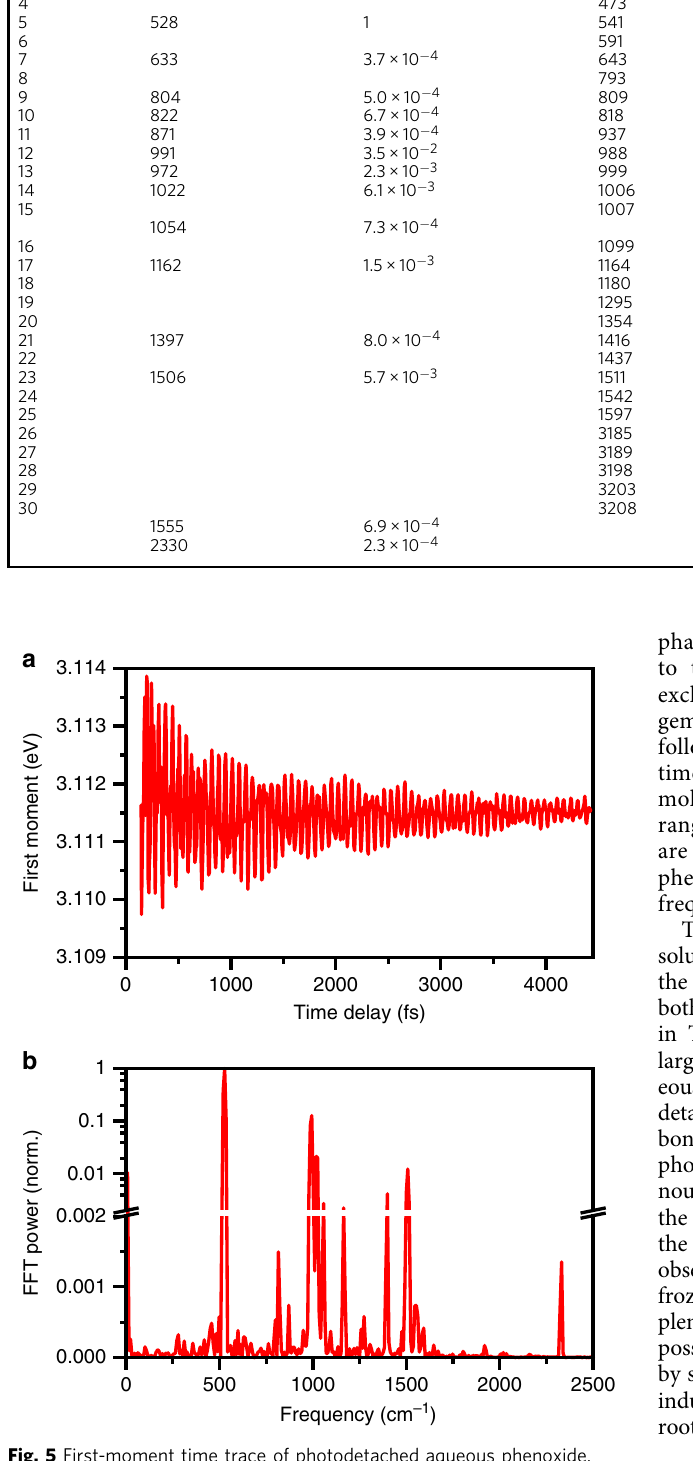
Fig. 5 First-moment time trace of photodetached aqueous phenoxide. (cid:2) (cid:3) obtained following the a First-moment time trace E 1 ð Þ t ð Þ photodetachment of phenoxide in aqueous solution. b Normalized Fast Fourier transform (FFT) power spectrum of the fi rst-moment time trace. Source data are provided as a Source Data fi le NATURE COMMUNICATIONS| (2019) 10:2944 |https://doi.org/10.1038/s41467-019-10989-1|www.nature.com/naturecommunications